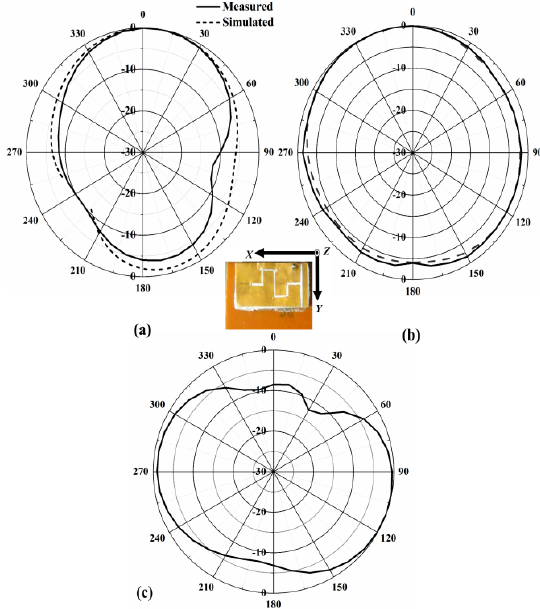
Figure 11: Measured and simulated 2-D principal plane pattern of the proposed antenna at 2.45 GHz (a) x-z plane (b) y-z plane (c) x-y